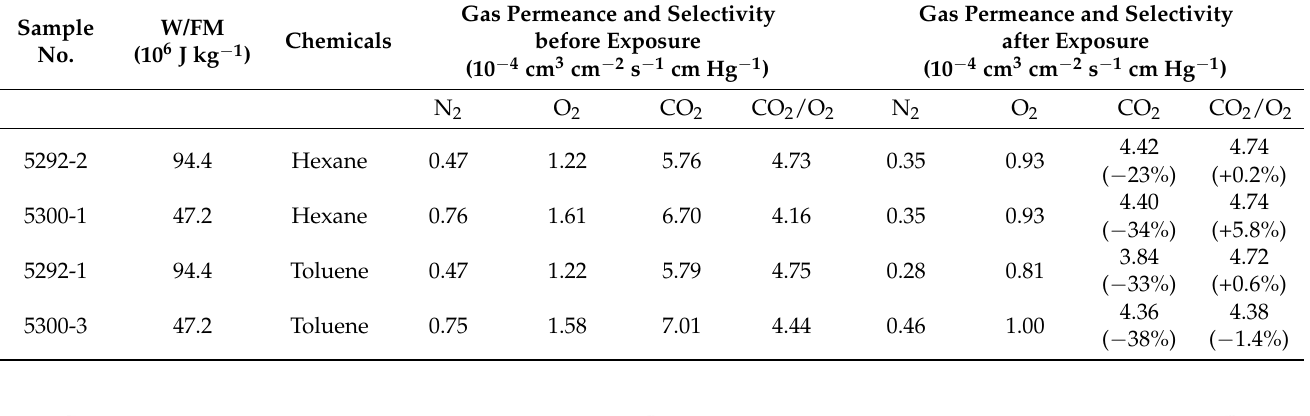
Table 18. Effect of composite parameter W/FM on change in gas permeability characteristics after solvent exposure.